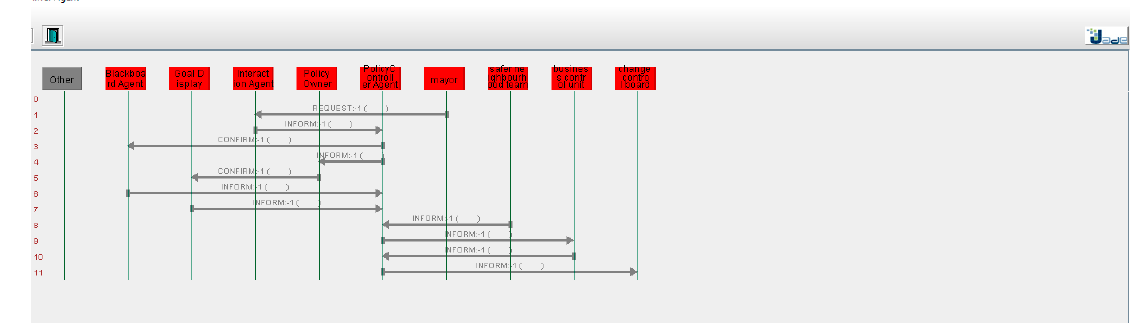
Figure 15. System Output-Different Process.